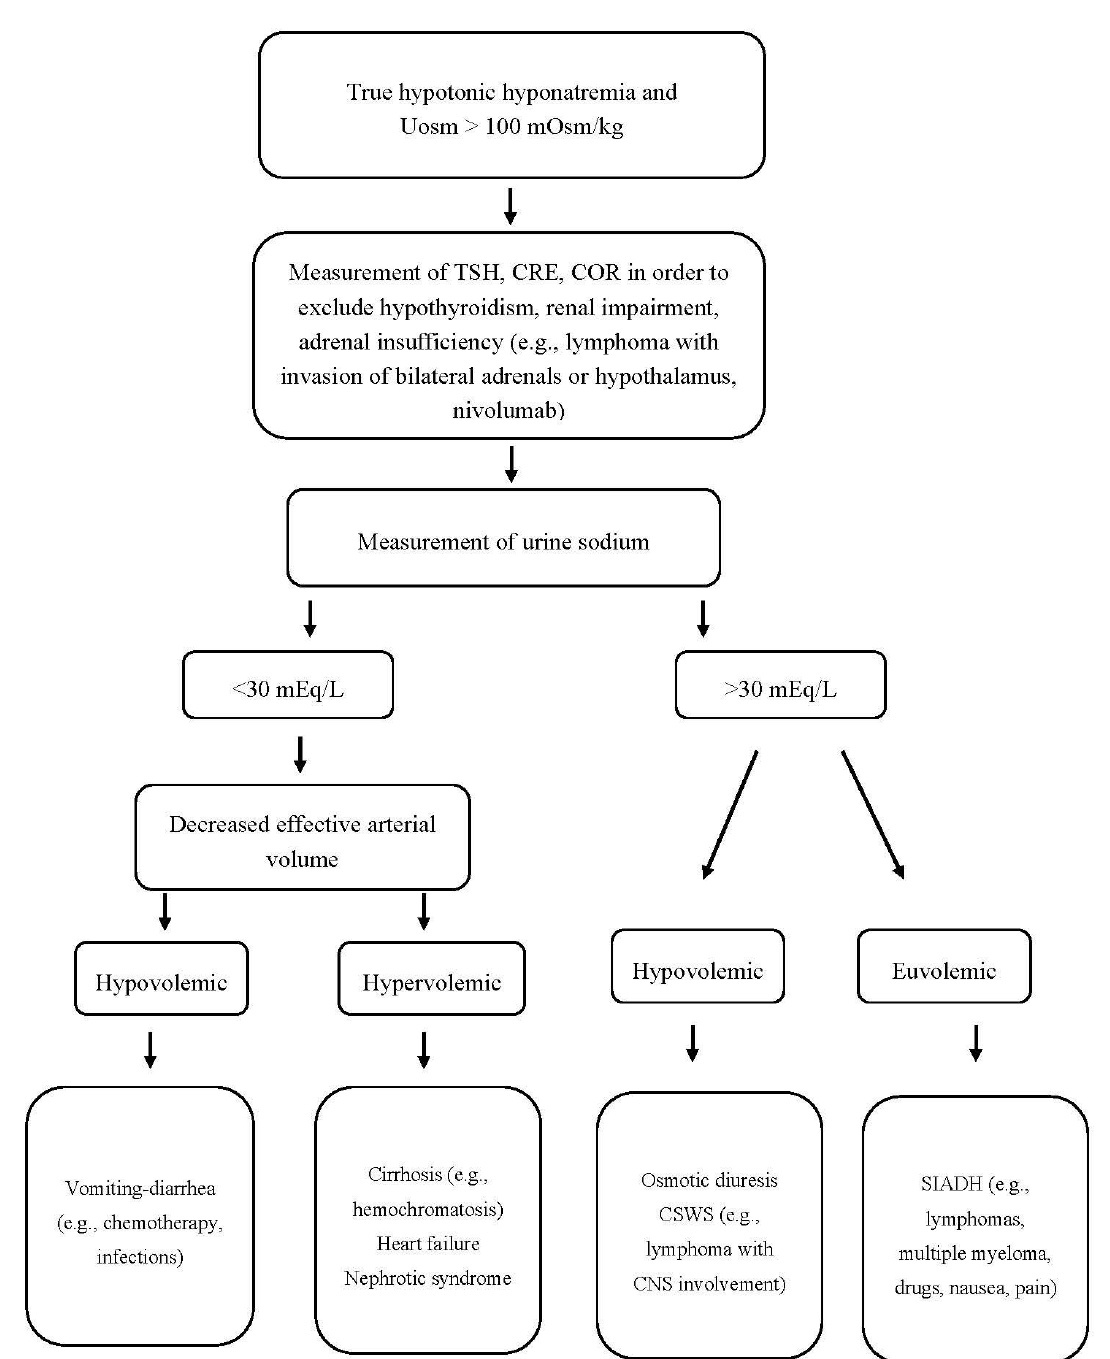
Figure 2. Approach to a patient with hypotonic hyponatremia, Uosm > 100 mOsm / kg, and hematologic disease. Uosm: urine osmolality, TSH: thyroid-stimulating hormone, CRE: creatinine, COR: cortisol, CSWS: cerebral salt wasting syndrome, SIADH: syndrome of inappropriate antidiuretic hormone secretion, CNS: central nervous system.